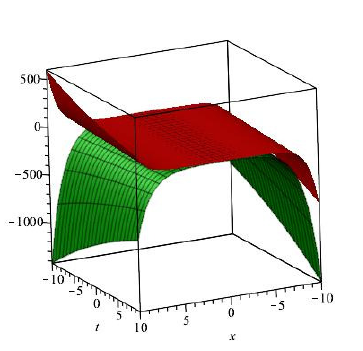
Figure 5. 3D plot of combined solution (3.14) by considering C 2 = 0, C 3 = 10, C 4 = − 1 , (cid:15) = 1 , positive sign for angle. Here, lining shade is used for u ( x,t ) (upper) 12 50 while plain shade is used for w ( x,t )